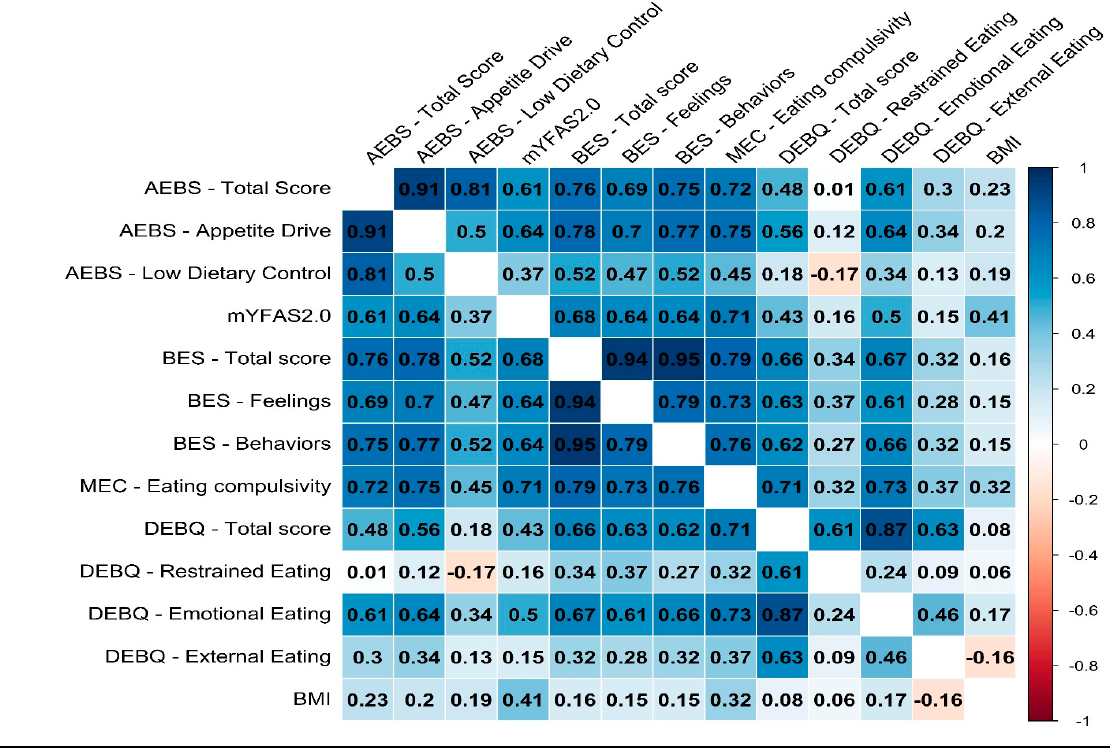
Figure 2. Correlations among